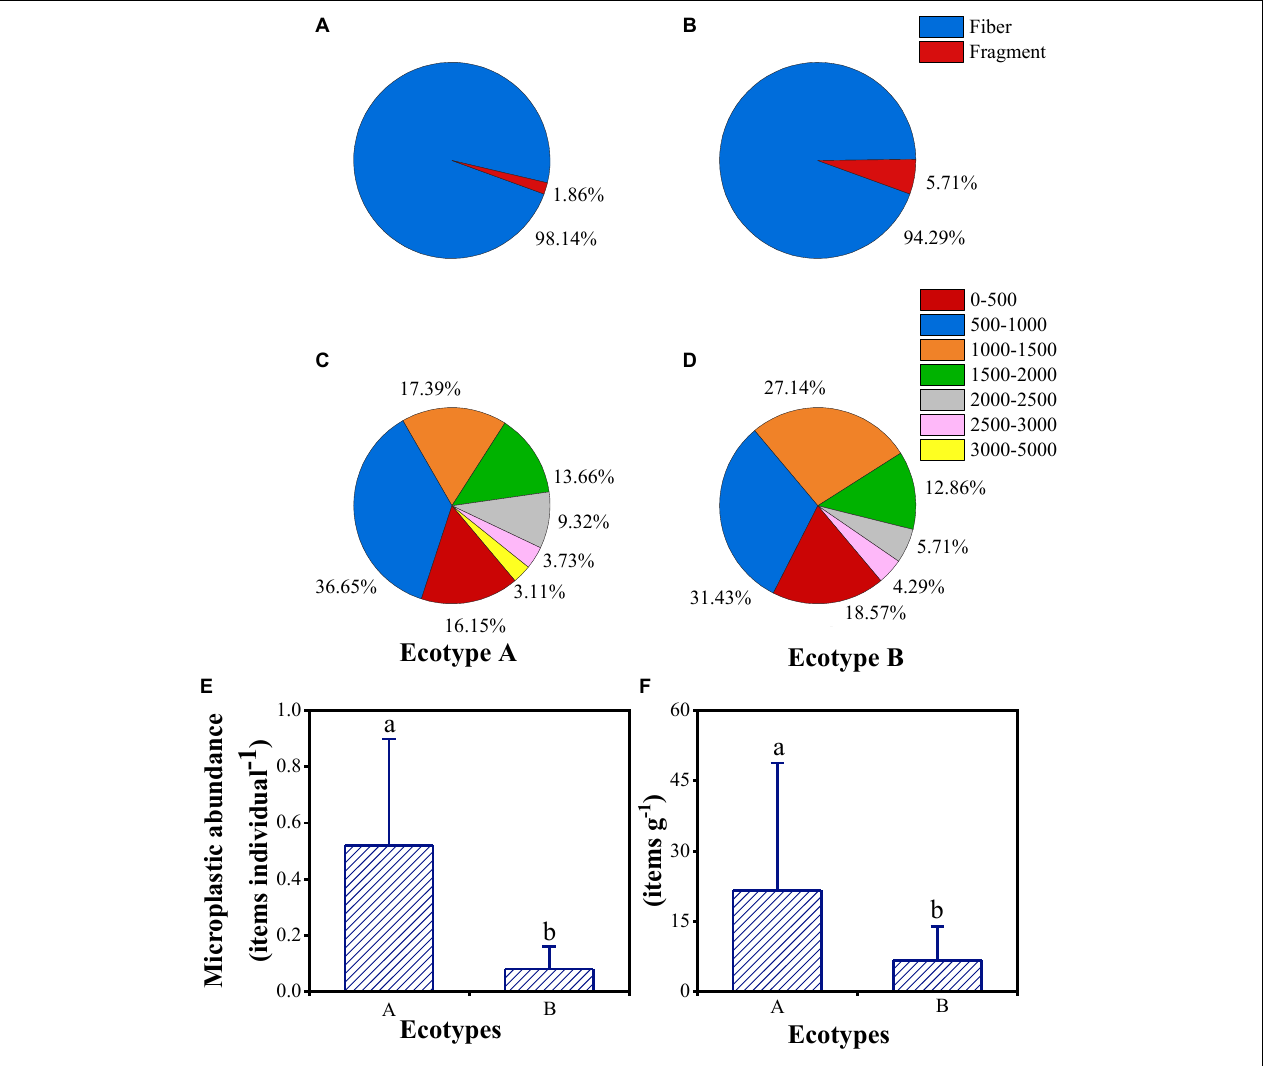
FIGURE 8 | The shape, size and abundance of MPs in ecotypes A (A,C,E) and B (B,D,F) of barnacles. Different letters above the bars indicate significant differences among ecotypes (one-way ANOVA, P < 0.05).